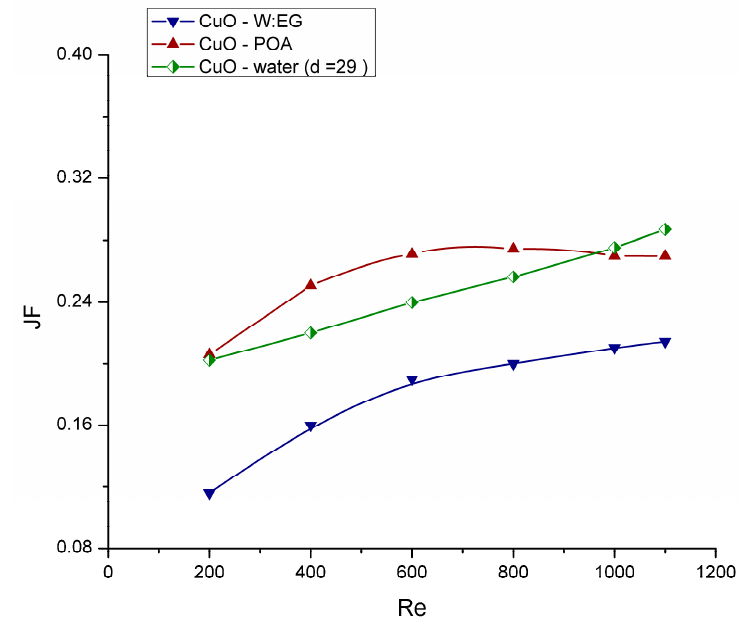
Figure 15. The effect of various base fluids and Reynolds number on the JF factor.